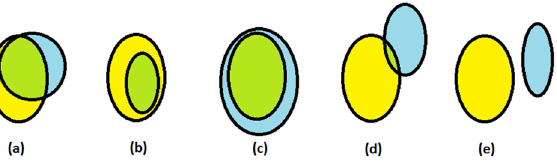
Figure 4. Schematic examples of the overlap evaluation (green colour) of candidate (blue colour) and ground truth (yellow colour). ( a–c ) were classified as found exudates. ( d,e ) were not classified as found exudates.